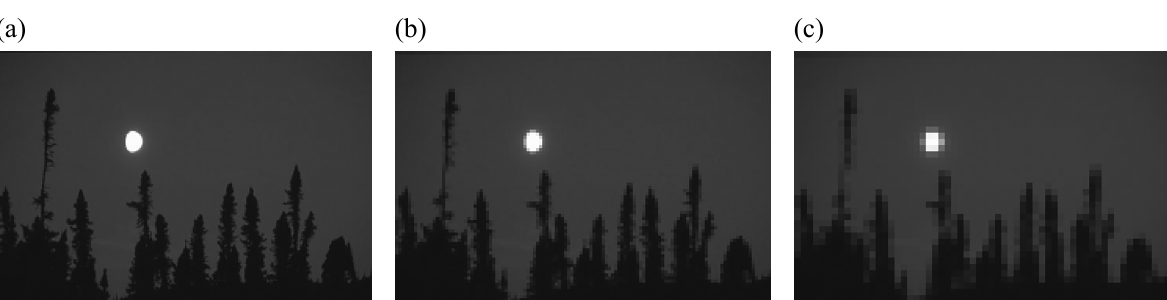
Fig. 6. The example of an image with LD where the Haar wavelet transformation is applied to three levels of decomposition.